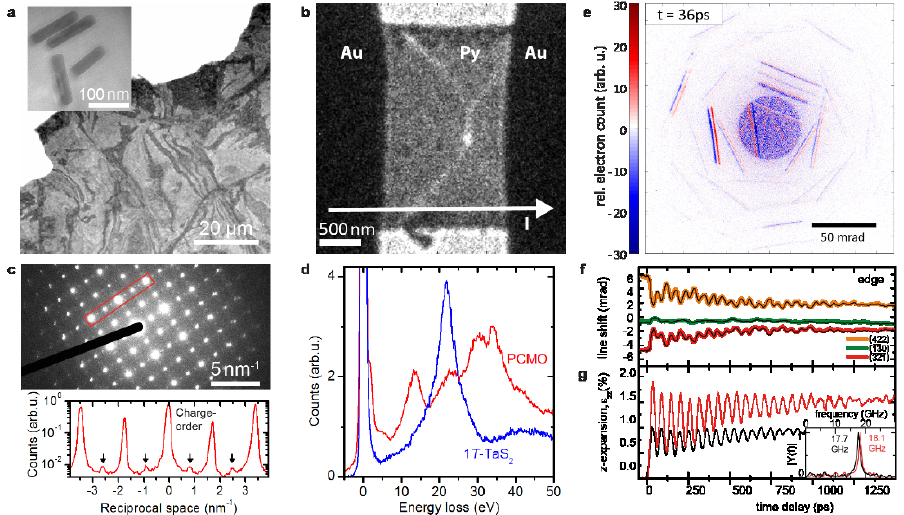
Fig. 1. Exemplary applications of the UTEM instrument. (a) Bright-field image of an ultra- microtomed 50 nm thin sample of 1T-TaS 2 , showing bending contrast of the thin-film membrane and drop-cast gold particles on the sample surface. (b) Lorentz imaging of the magnetic domain structure in a 20 nm thick permalloy square contacted by two gold electrodes. (c) Diffraction pattern of the charge-ordered phase of ion-polished PCMO. (d) Electron energy loss spectra of 1T-TaS 2 and PCMO. (e) Time-dependent Bragg-line changes of a single-crystalline graphite flake. (f) Experimentally obtained delay-dependent center-of-mass shift (black line) and reconstructed mean line position (colored line) of the (422), (-1-30) and (-3-2-1) Bragg lines, probed at the graphite edge. (g) Reconstructed z-axis expansion with Fourier analysis (inset, |Y(f)|: Fourier amplitude) (Figure adapted from Ref.